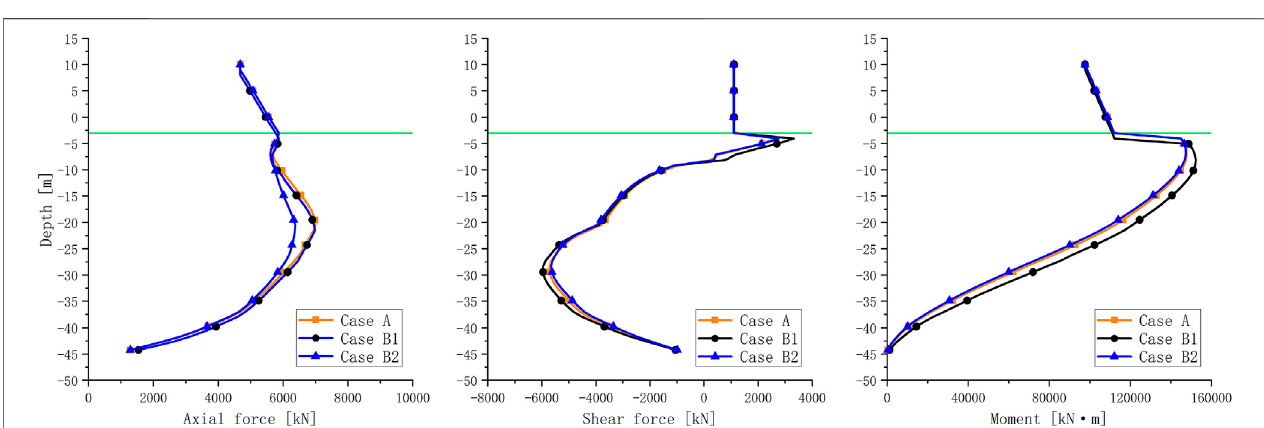
FIGURE 8 | The pro fi le of the internal axial force, shear force, and moment in the SLS.